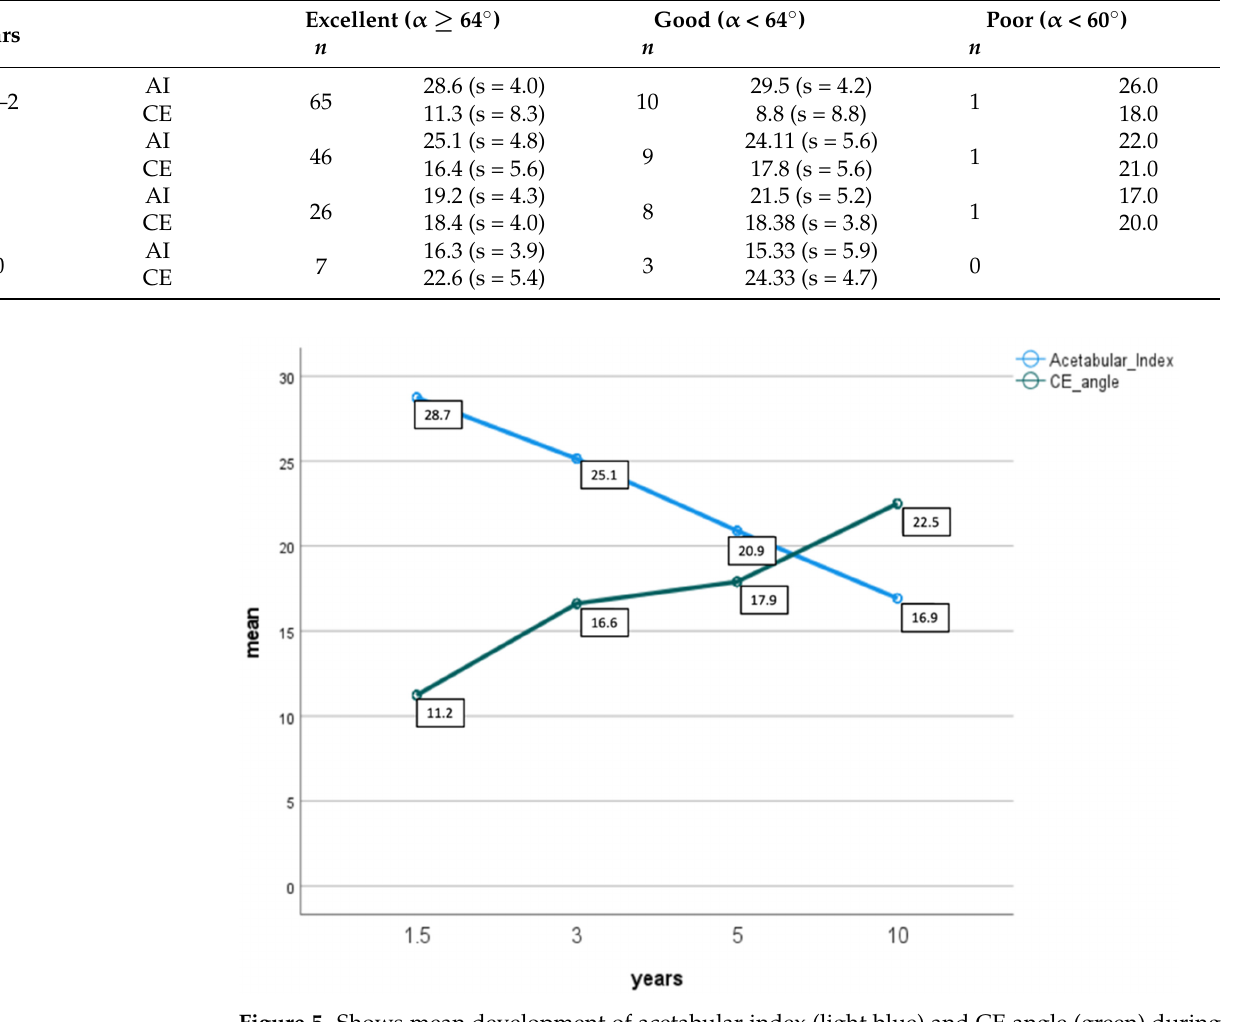
Figure 5. Shows mean development of acetabular index (light blue) and CE angle (green) during follow-up after 1.5, 3, 5 and 10 years.